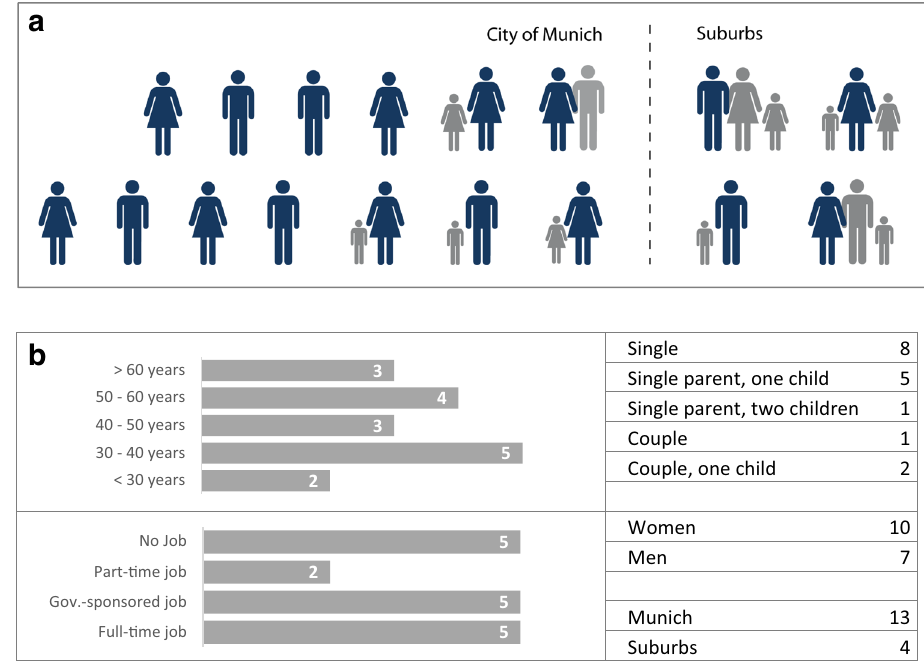
Fig. 3 a Household structure, gender and residential location